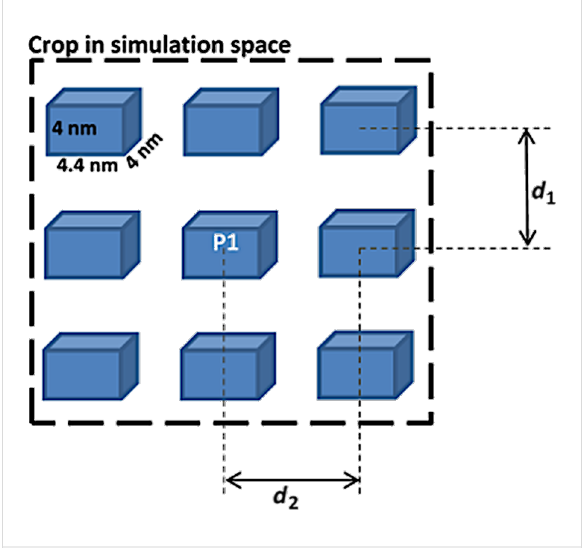
Figure 2: The specific geometry of magnetic nanoparticles in the micromagnetic simulations. Different configurations may be obtained for different couples of d 1 and d 2